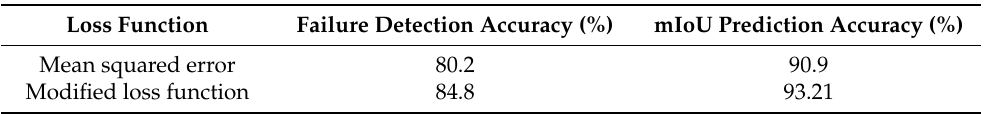
Table 8. Failure detection and mIoU prediction accuracy for the different loss function on Cityscape dataset.